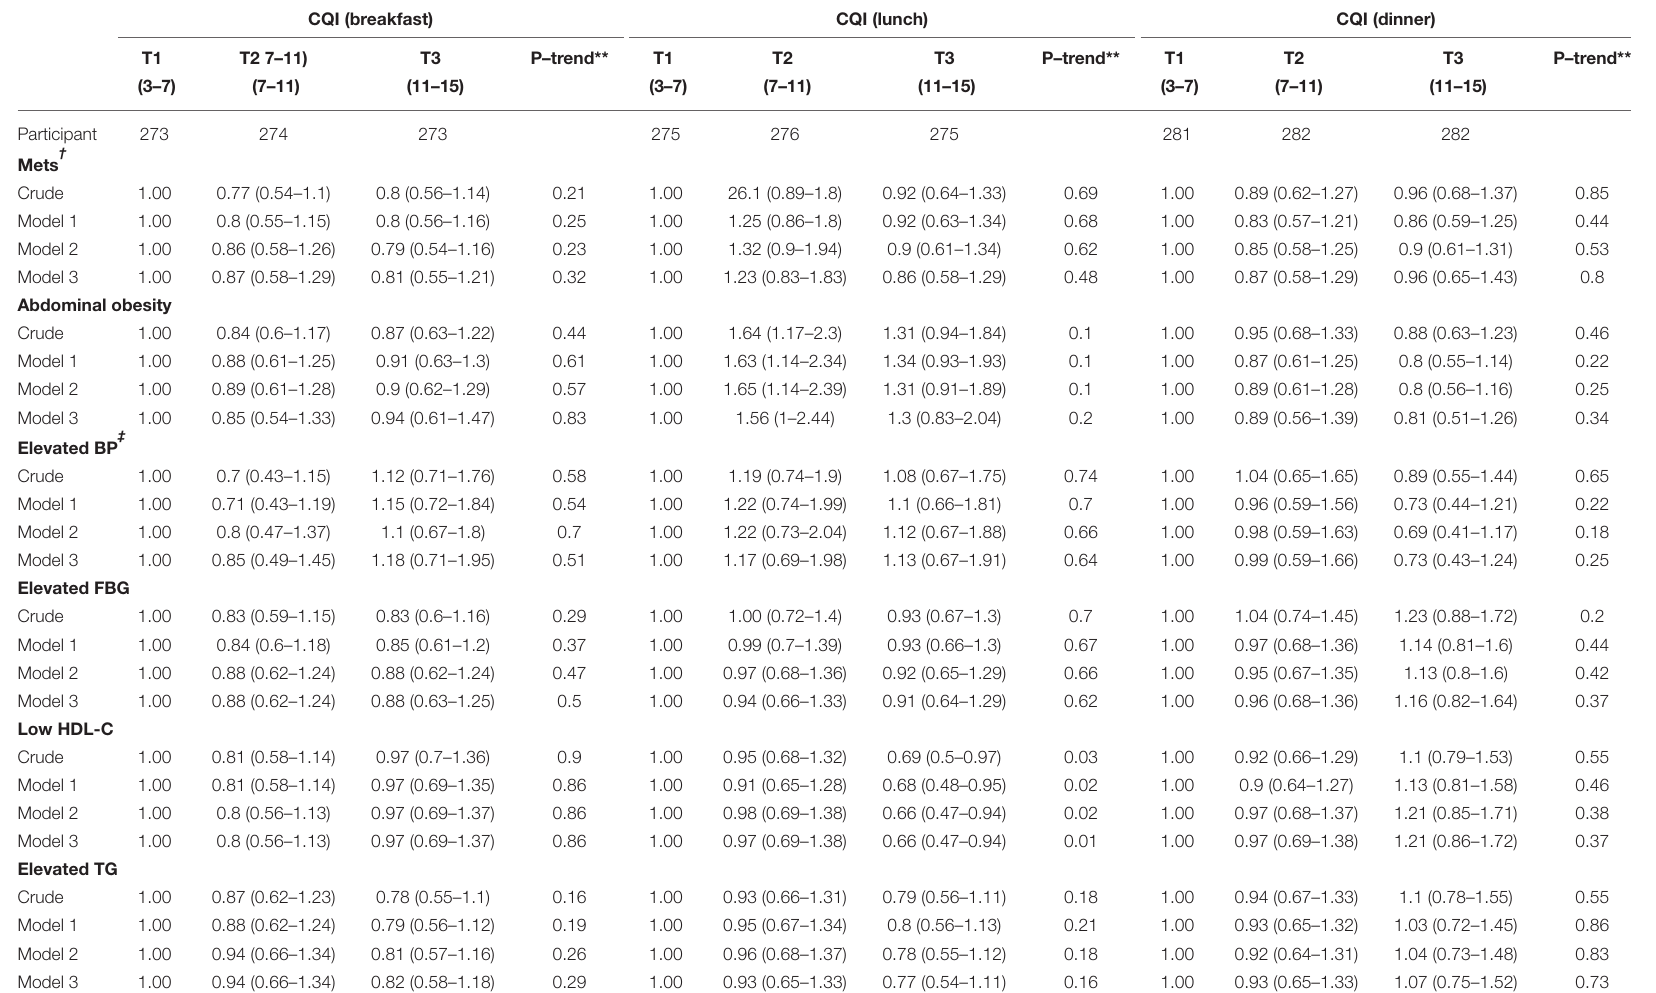
TABLE 4 | OR and 95%CI for metabolic syndrome and components among the study participants according to tertiles (T) of CQI in